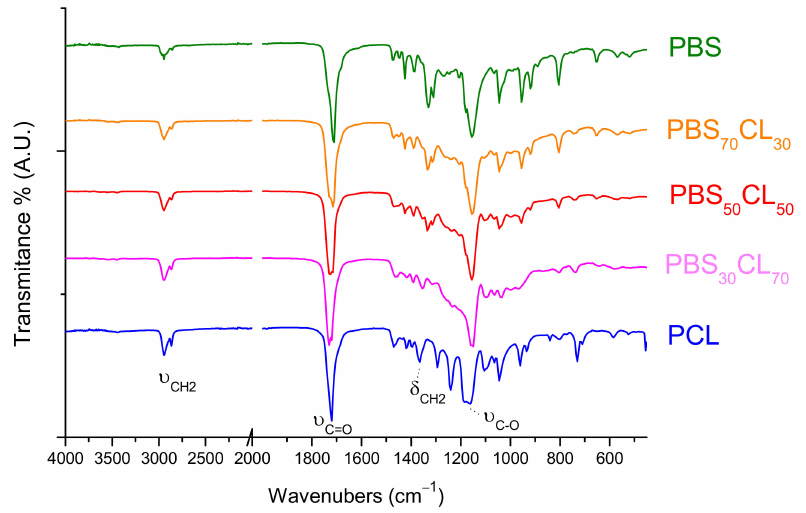
Figure 4. FTIR spectra of PBS, PCL, and PBS x CL y copolyesters.